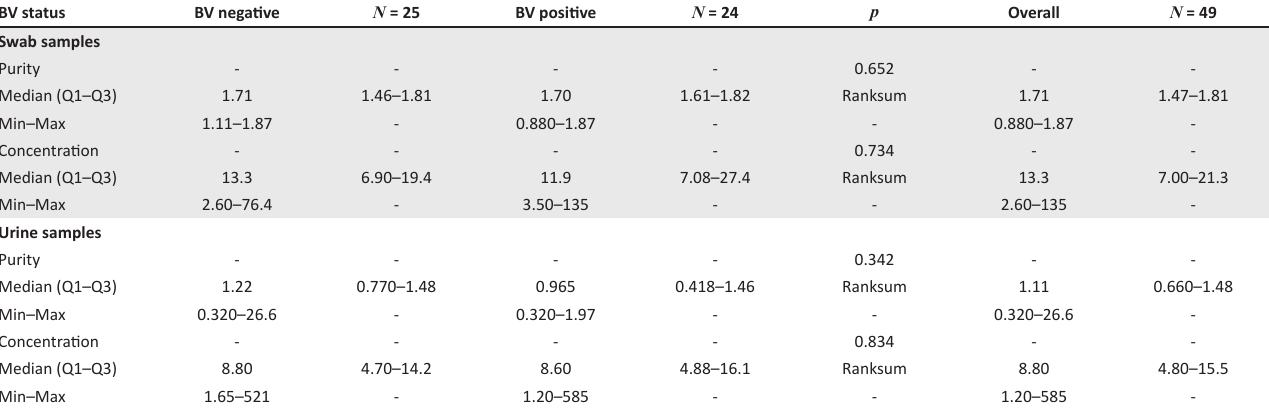
TABLE 1-A1: Median value for the deoxyribonucleic acid purity and concentration values in swab and urine samples across the bacterial vaginosis (BV) states. BV